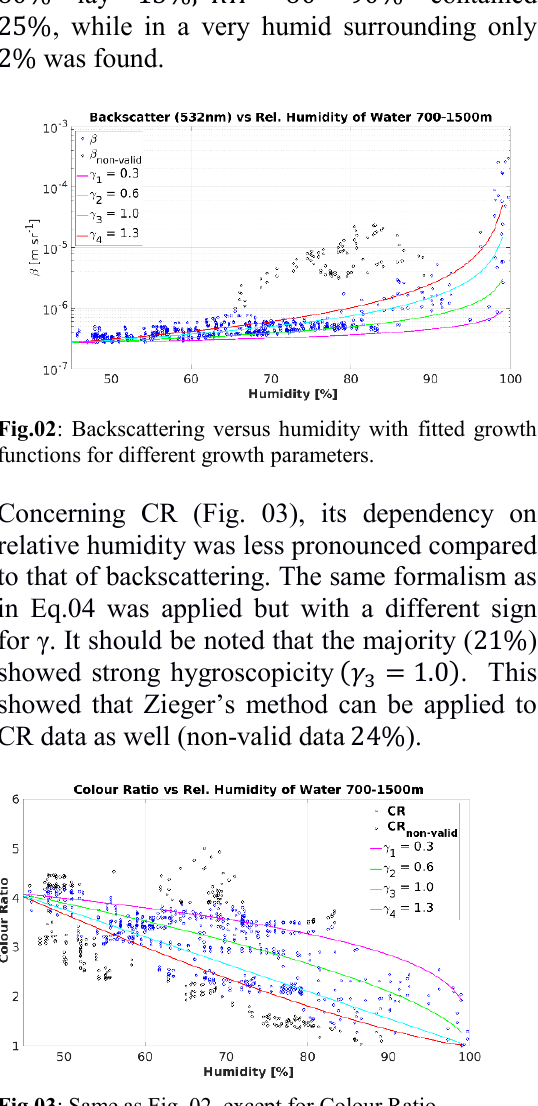
Fig.03 : Same as Fig. 02, except for Colour Ratio.